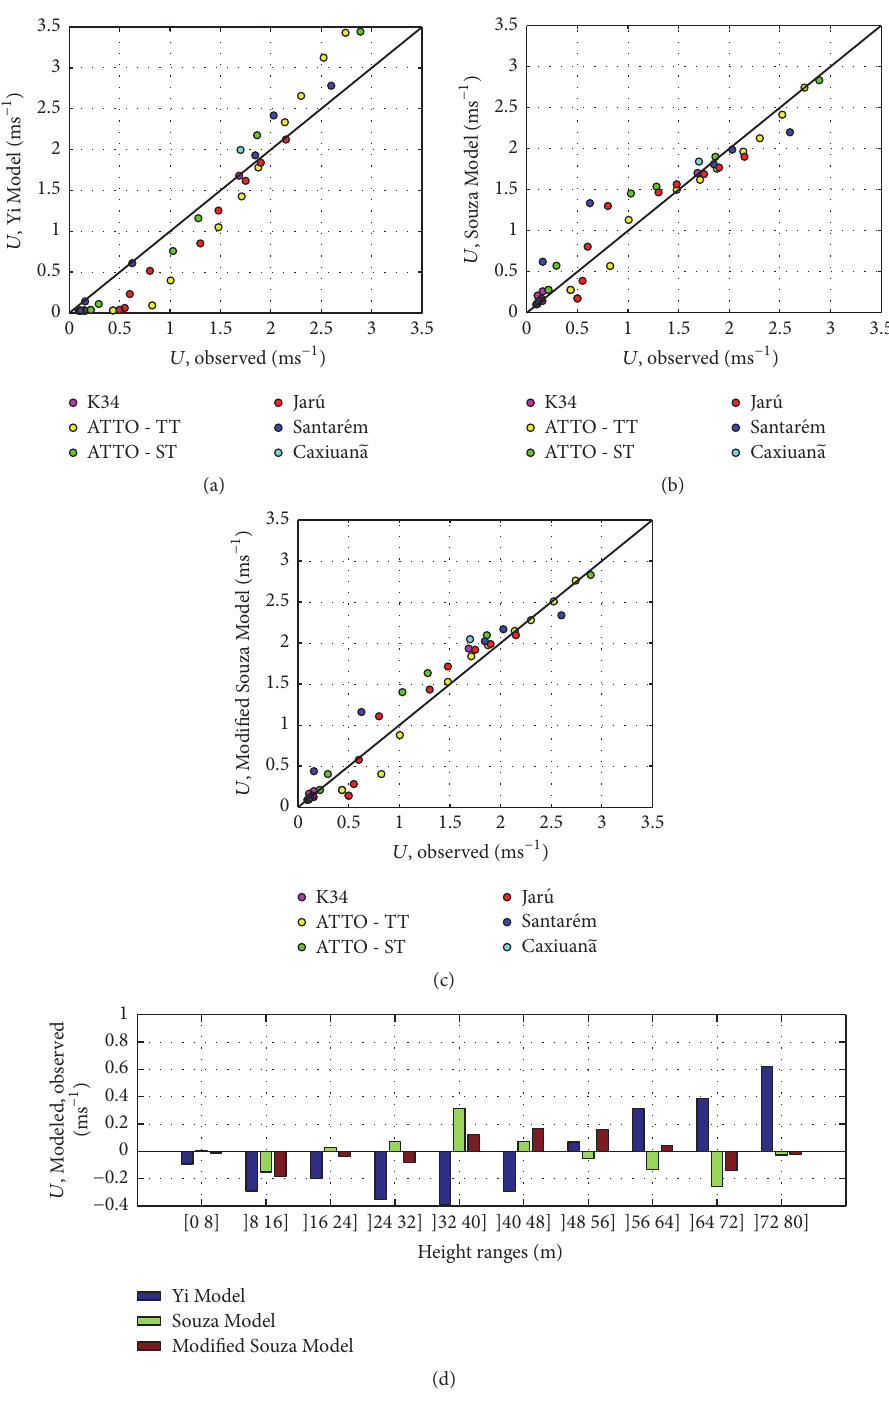
Figure 6: Wind speed ( U ) observed versus modeled for the three models used in this study ((a), (b), and (c)). Part (d) shows the modeled minus observed wind speed for different intervals of heights, above and below the forest canopy.